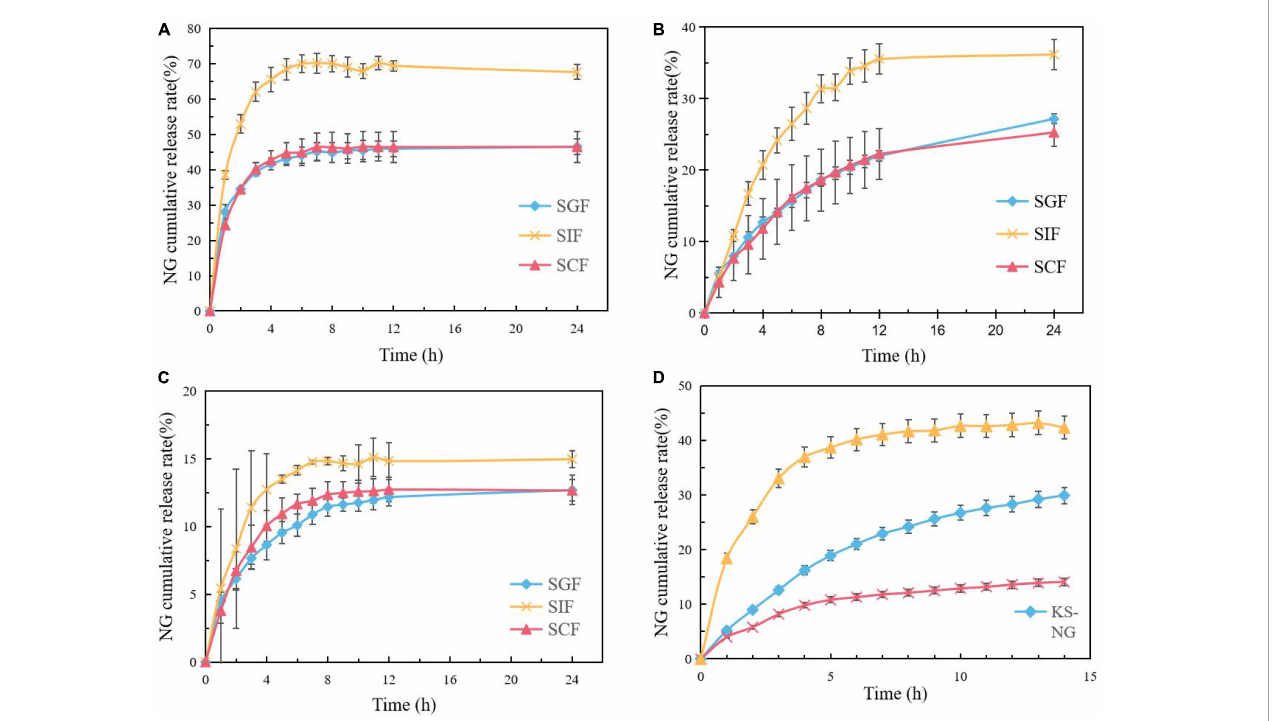
FIGURE8 Release profiles of NG from NG/MSN at SGF, SIF, and SCF (A) , release profiles of NG from KS/NG at SGF, SIF, and SCF (B) , release profiles of NG from KS/NM at SGF, SIF, and SCF (C) , release profiles of NG from NM, KS/NG, and KS/NM in SGF for 2 h and subsequently in SIF (D) .